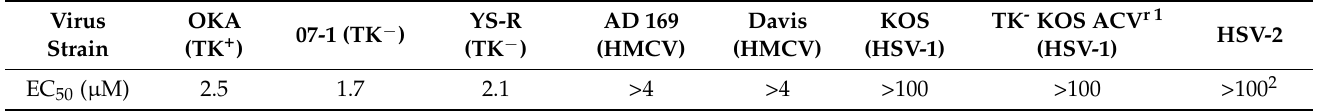
Table 2. Activity of compound 12 against various viral strains [22].